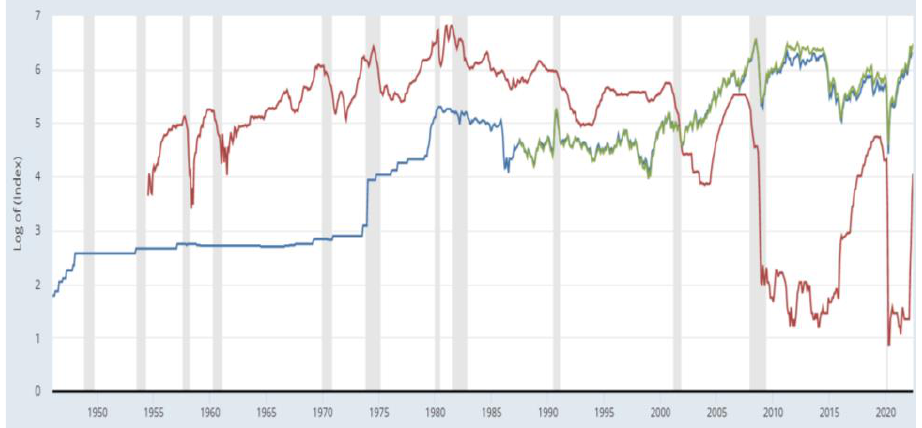
Figure 1 : Spot Crude Oil Price West Texas Intermediate (WTI), Federal Funds Effective Rate, Crude oil prices Brent-Europe. Source: St.Louis Federal Reserve; Board of